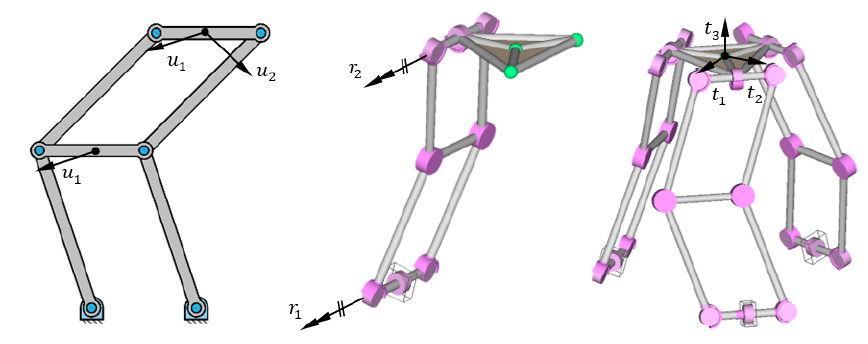
Figure 2. Micro Finger manipulator (three translations t 1 , t 2 and t 3 ).